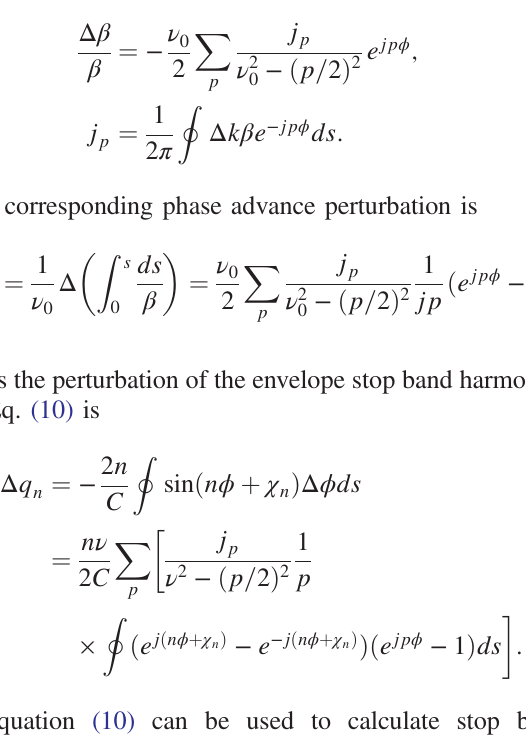
FIG. 5. An example of quadrupole errors and strength for the correction. Ten trim quadrupoles are